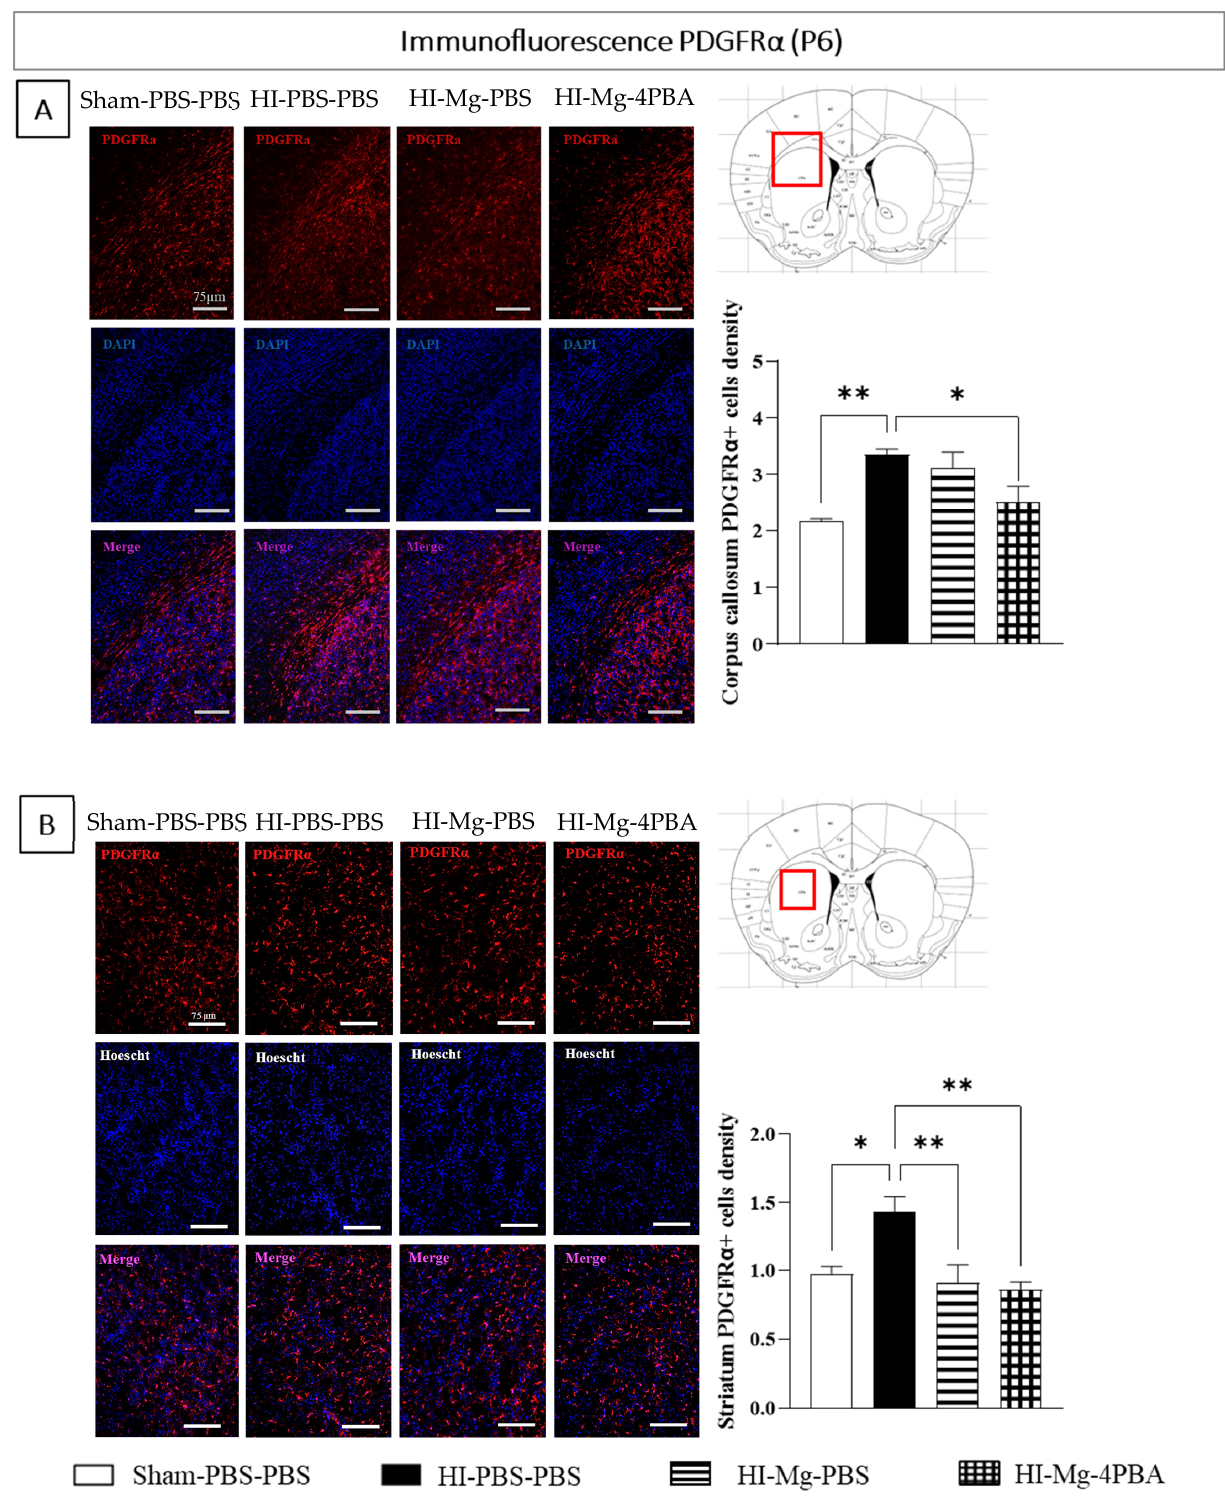
Figure 6. Effects of neonatal HI, MgSO 4 or of the MgSO 4 /4-PBA association on PDGFR α density in the corpus callosum and striatum at P6. ( A )—PDGFR α labeling immunofluorescence and quantification of PDGFR α + cells density in the corpus callosum. ( B )—PDGFR α labeling immunofluorescence and quantification of PDGFR α + cells density in the striatum. Sexes are pooled. Data are expressed as M ± S.E.M, n = 5–6 pups/group. One-way ANOVA was performed followed by Tukey’s post-test. (* p < 0.05, ** p <